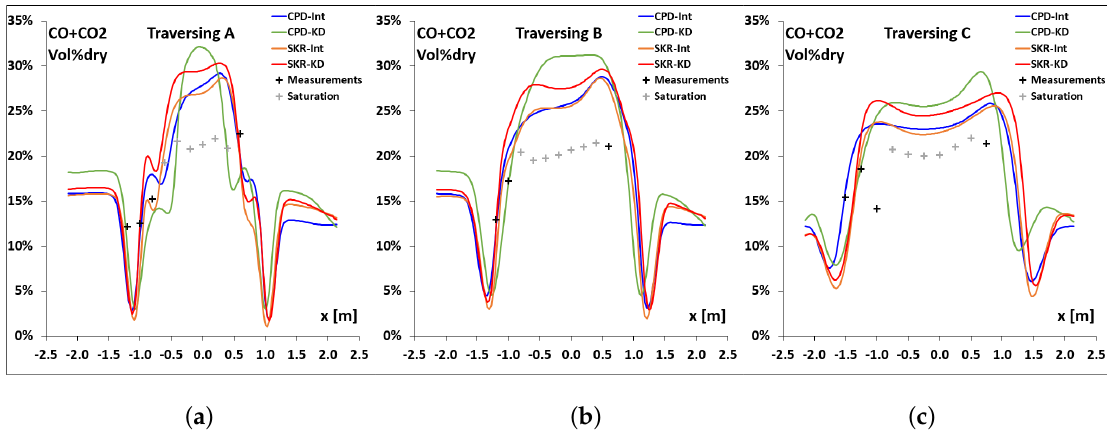
Figure 17. CO + CO 2 molar concentrations distribution along Traverses A ( a ), B ( b ) and C ( c